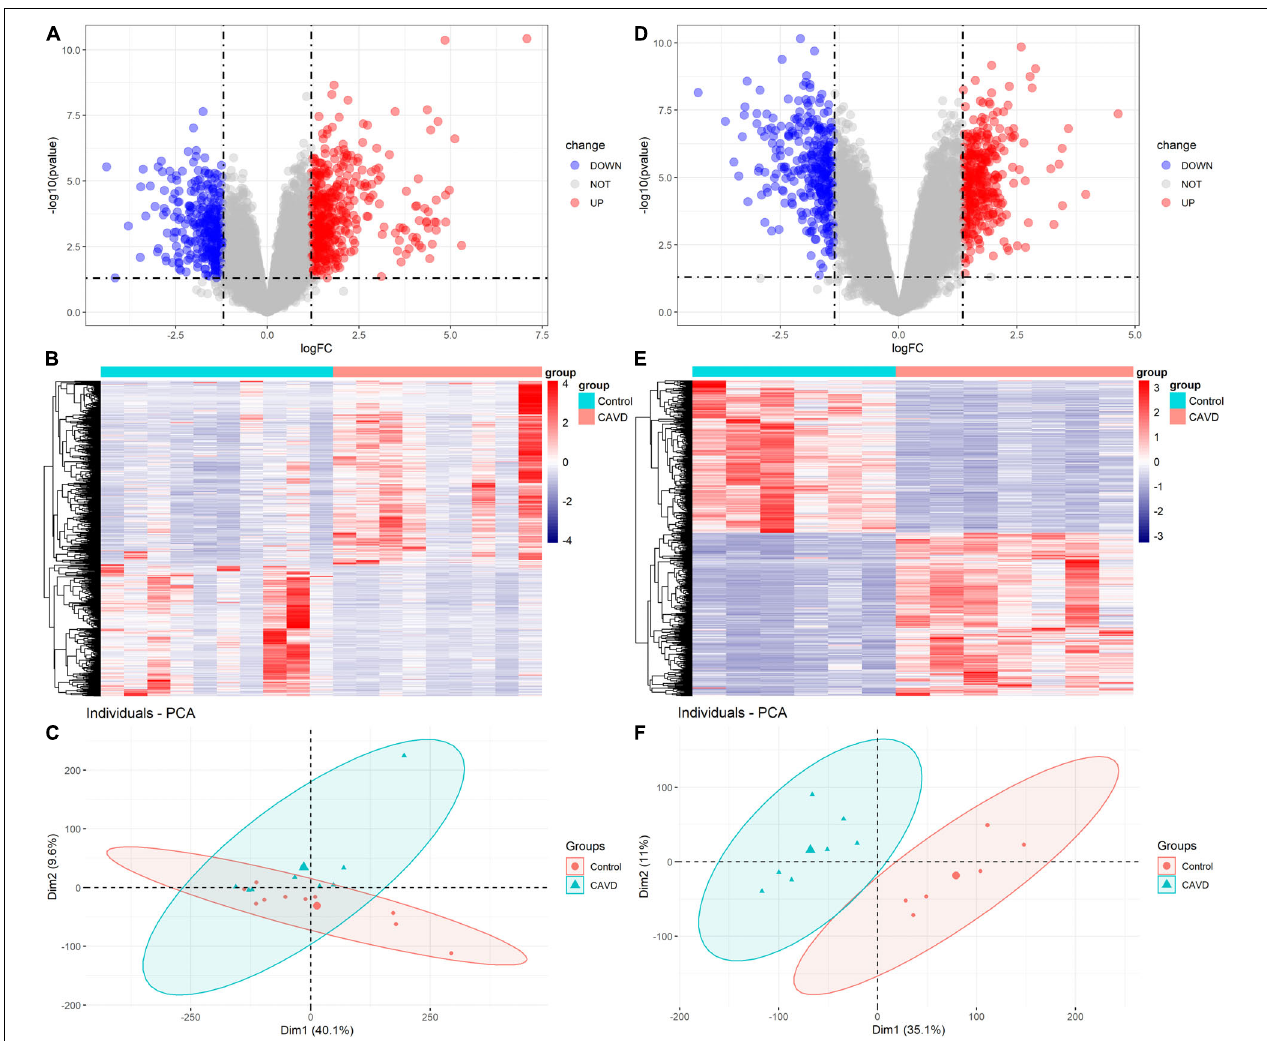
FIGURE 2 | Volcano plots, heatmaps, and PCA plots of differentially expressed mRNAs. (A) Volcano plot of differentially expressed mRNAs in GSE55492; (B) Heatmap of differentially expressed mRNAs in GSE55492; (C) PCA plot in GSE55492; (D) Volcano plot of differentially expressed mRNAs in GSE148219; (E) Heatmap of differentially expressed mRNAs in GSE148219; (F) PCA plot in